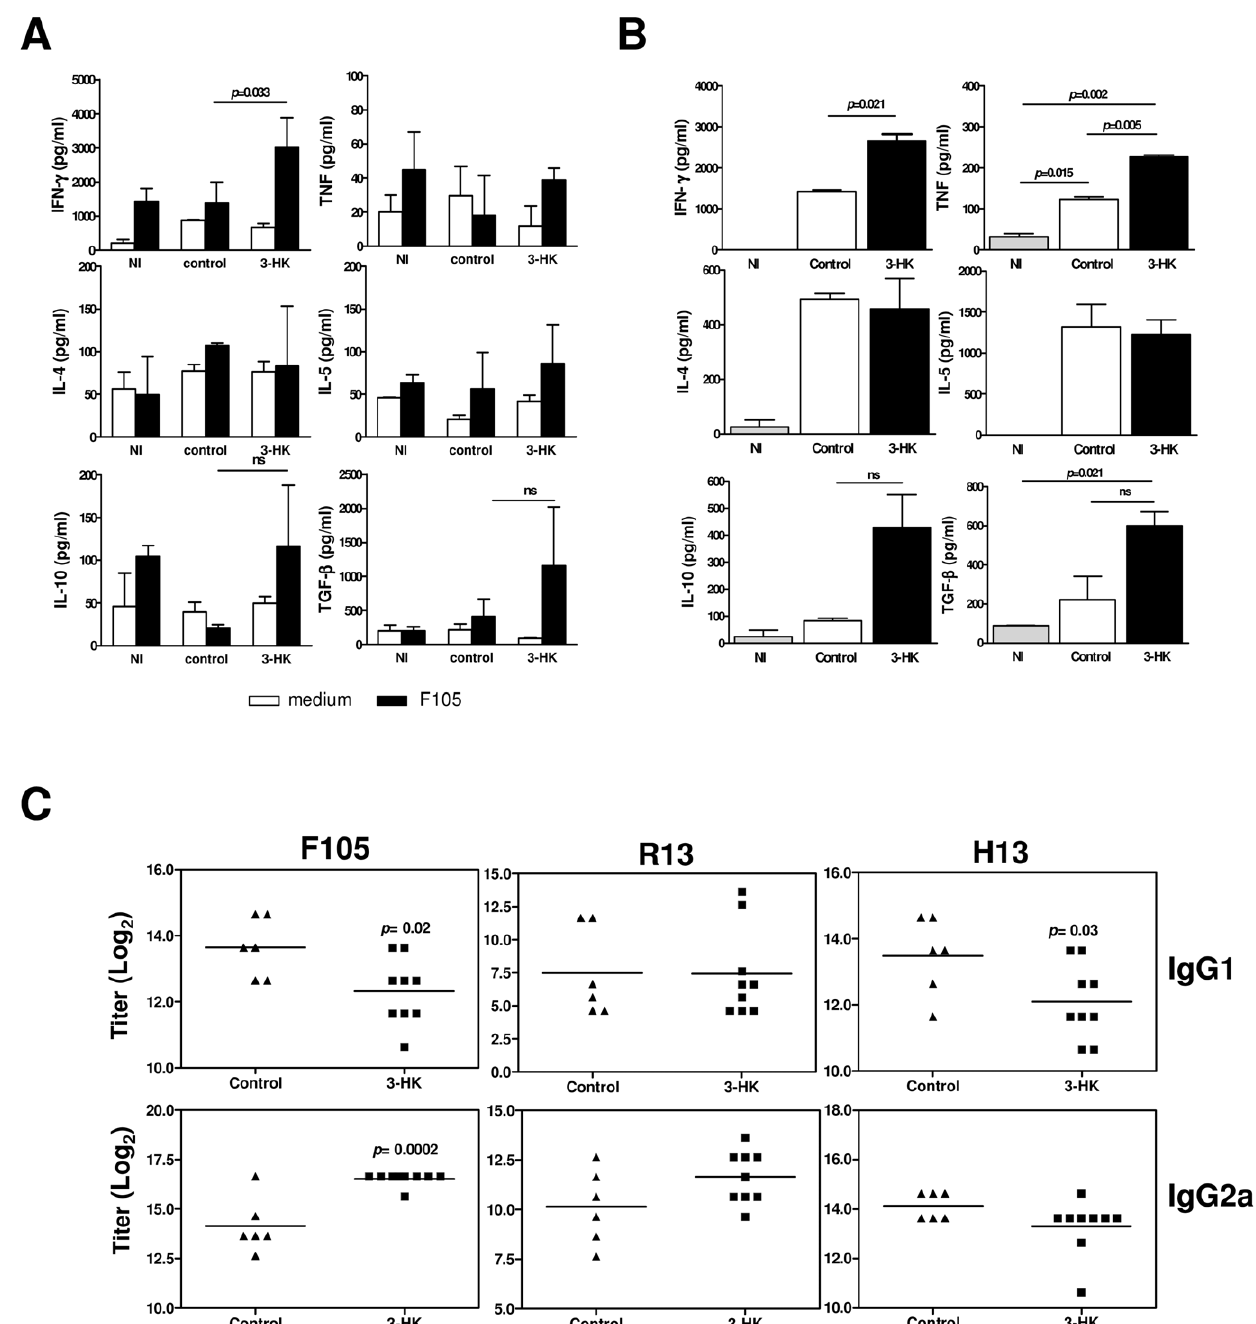
Figure 4. 3-HK treatment induces a long-term Th1-type cellular and humoral immune response against T.cruzi . (A) SMC from 3-HK (n=4) or control (n=4) mice isolated at 60 dpi or from non-infected (NI) mice (n=4) were cultured with or without 15 m g/ml of F105. After 72 h, supernatant were collected and the levels of secreted IFN c , TNF, IL-4, IL-5, IL-10 and TGF- b determined by ELISA. Bars represent the mean values 6 SD from 4 mice/group. These results are from one of three similar experiments, all of which gave similar data. (B) Plasma IFN- c , TNF, IL-4, IL-5, IL-10 and TGF- b concentration in 3-HK (n=4) and control (n=4) 60-day T. cruzi- infected mice or non-infected (NI) mice. Data are shown as mean 6 SD, n=4 mice per group. (C) Sera from 3-HK or control mice at 60 dpi were assayed for detection of IgG1 and IgG2a isotypes of antibodies against F105, R13 and H13 by ELISA. Titrations were performed in duplicate, and the end point was expressed as the serum dilution with an optical density twice as high as those of the corresponding NI